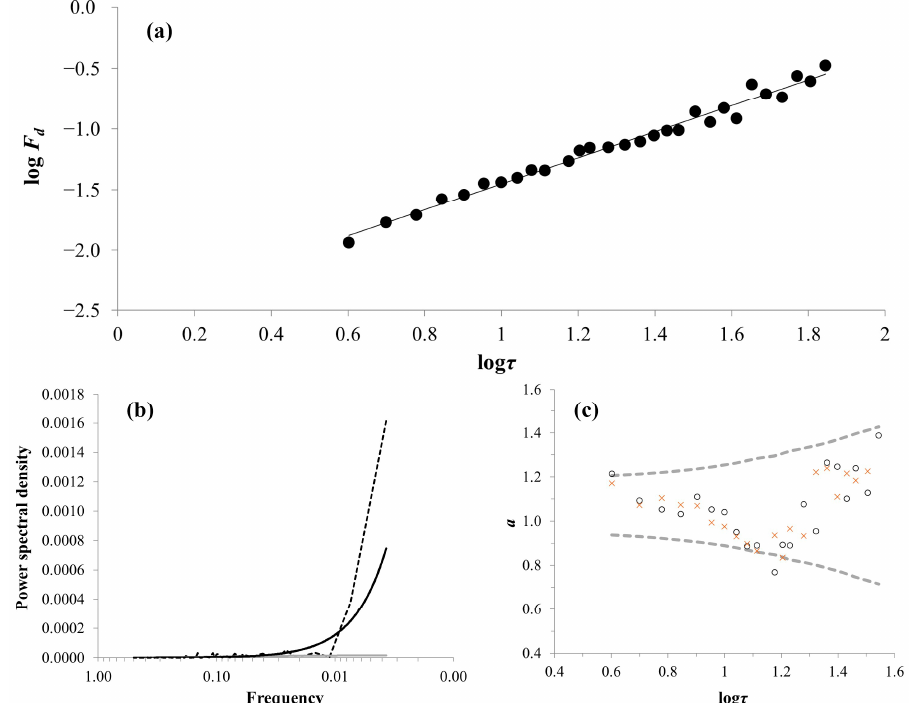
Figure 3. ( a ) Log–log plot of the root mean square fluctuation function, F d , for the 25-year fixed-step humification versus the time interval τ (in 25-year steps) and the corresponding best fit equation (y = 1.07·x − 2.52, R 2 = 0.98). ( b ) Power spectral density for the initial timeseries (dashed black line) with the corresponding power-law (black solid line) and exponential (gray solid line) fit (y = 0.0000001·x − 1.58 , R 2 = 0.52; y = 0.00001701·e − 9.71·x , R 2 = 0.59). ( c ) Local slopes stability of log F d ( τ ) vs. log τ calculated for a 10-point window (red crosses) and a 9-point window (black circles) for the 25-year fixed-step timeseries. The dashed gray line illustrates the corresponding 2 σ range, derived from the 500 fractional noise simulations.